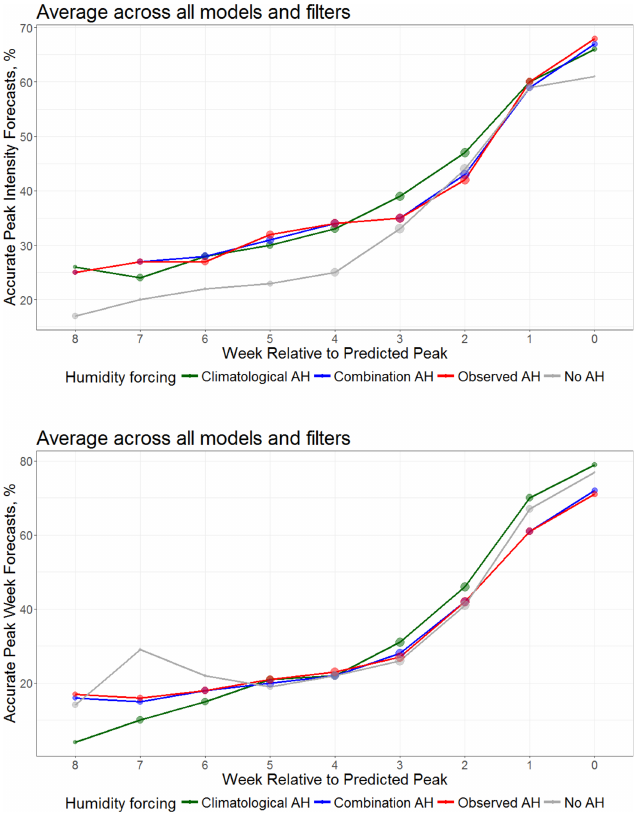
Fig 1. Percentage of forecasts accurate for predictions of peak intensity (top, within ± 25%of observed peak intensity) and peak timing (bottom, within ± 1 week of the observed peak) plotted as a function of forecastlead relative to the predicted peak. Shown are the forecast accuraciesfor models with climatological AH forcing (green), observed AH forcing (red), a combination of observedAH during optimizationand climatological AH duringforecast (blue), and no AH forcing (grey). The numberof forecasts (log transformed) at each lead is representedby the size of the